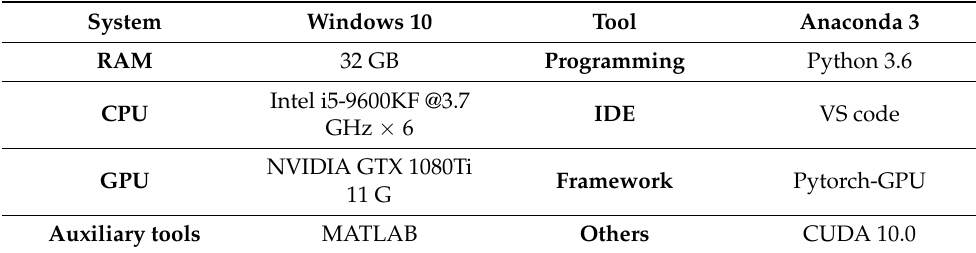
Table 1. Experimental